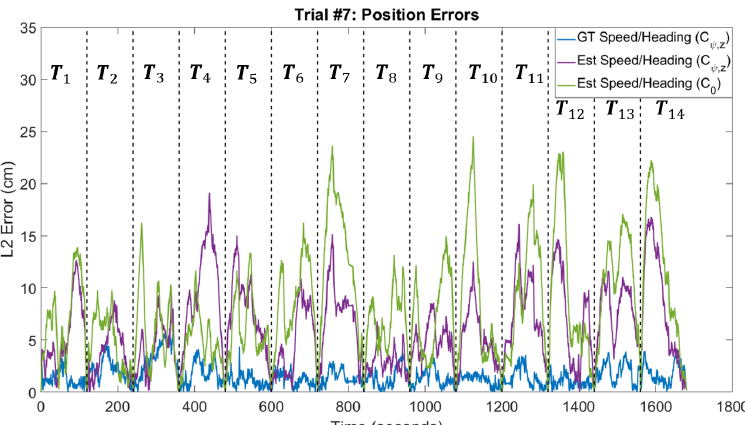
Figure 16. Trial #7 Position Errors: Distance between the ground truth and estimated position trajectories for varying algorithm configurations. T i denotes the ith trajectory segment. Configuration C 0 : Detrended AHRS output, no heading correction regression model, and no stationarity detection. Configuration C ψ , z : Full heading correction model and estimated stationary labels.